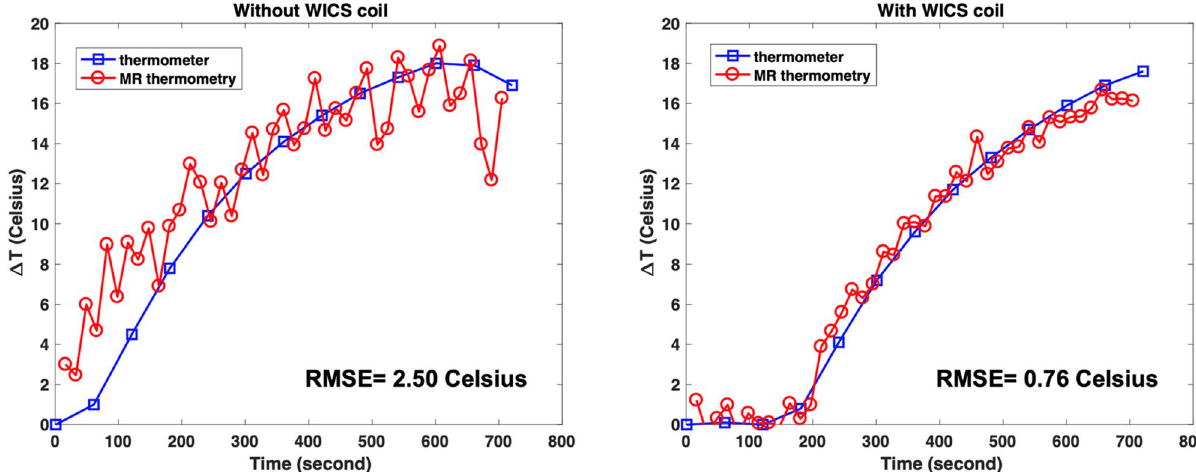
Figure 7. Temperature response during MR thermal mapping validation study (hot water experiment) measured simultaneously by the fiber-optic thermometer and MR thermometry scanned with and without WICS